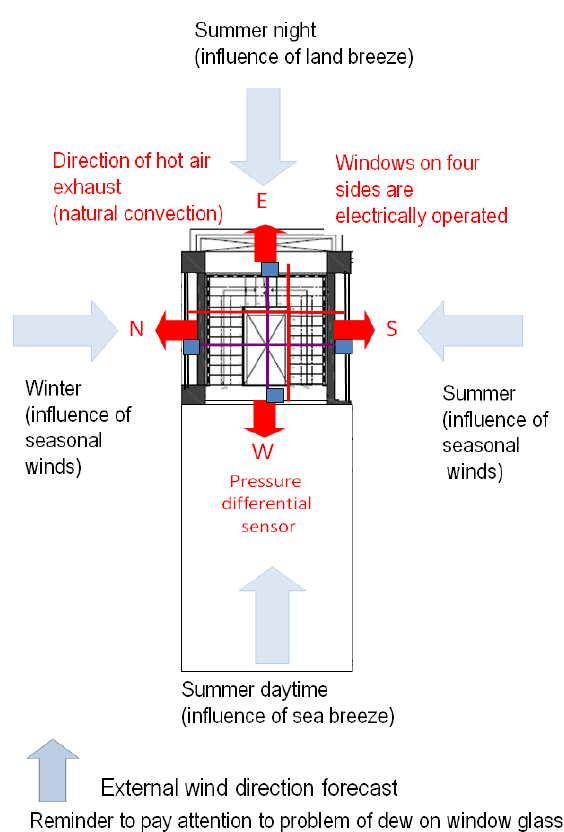
Figure 8. Ventilation tower air shutter opening and shutting